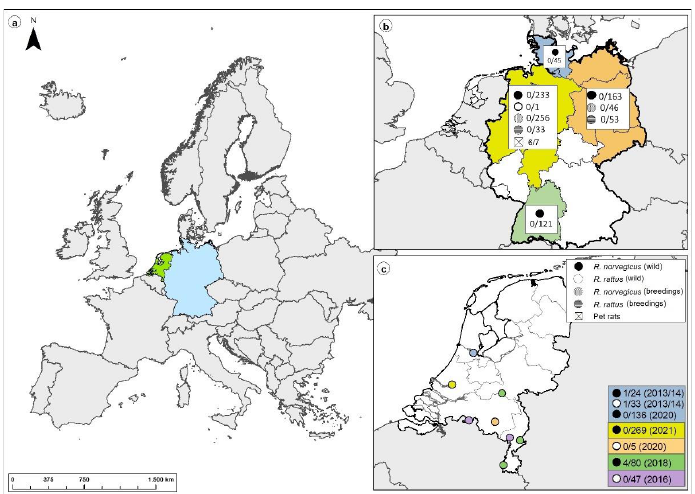
Figure 1. Location of Norway and black rat collection sites in Europe ( a ), Germany (wild-trapped rats and rats from breeding colonies) ( b ), and in the Netherlands (wild-trapped rats) ( c ). Map of the Netherlands ( c ): Amsterdam (blue); Rotterdam (yellow); Eindhoven (orange); Appeltern, Roermond, and Maastricht (green); and various municipalities of North Brabant and Limburg (purple).